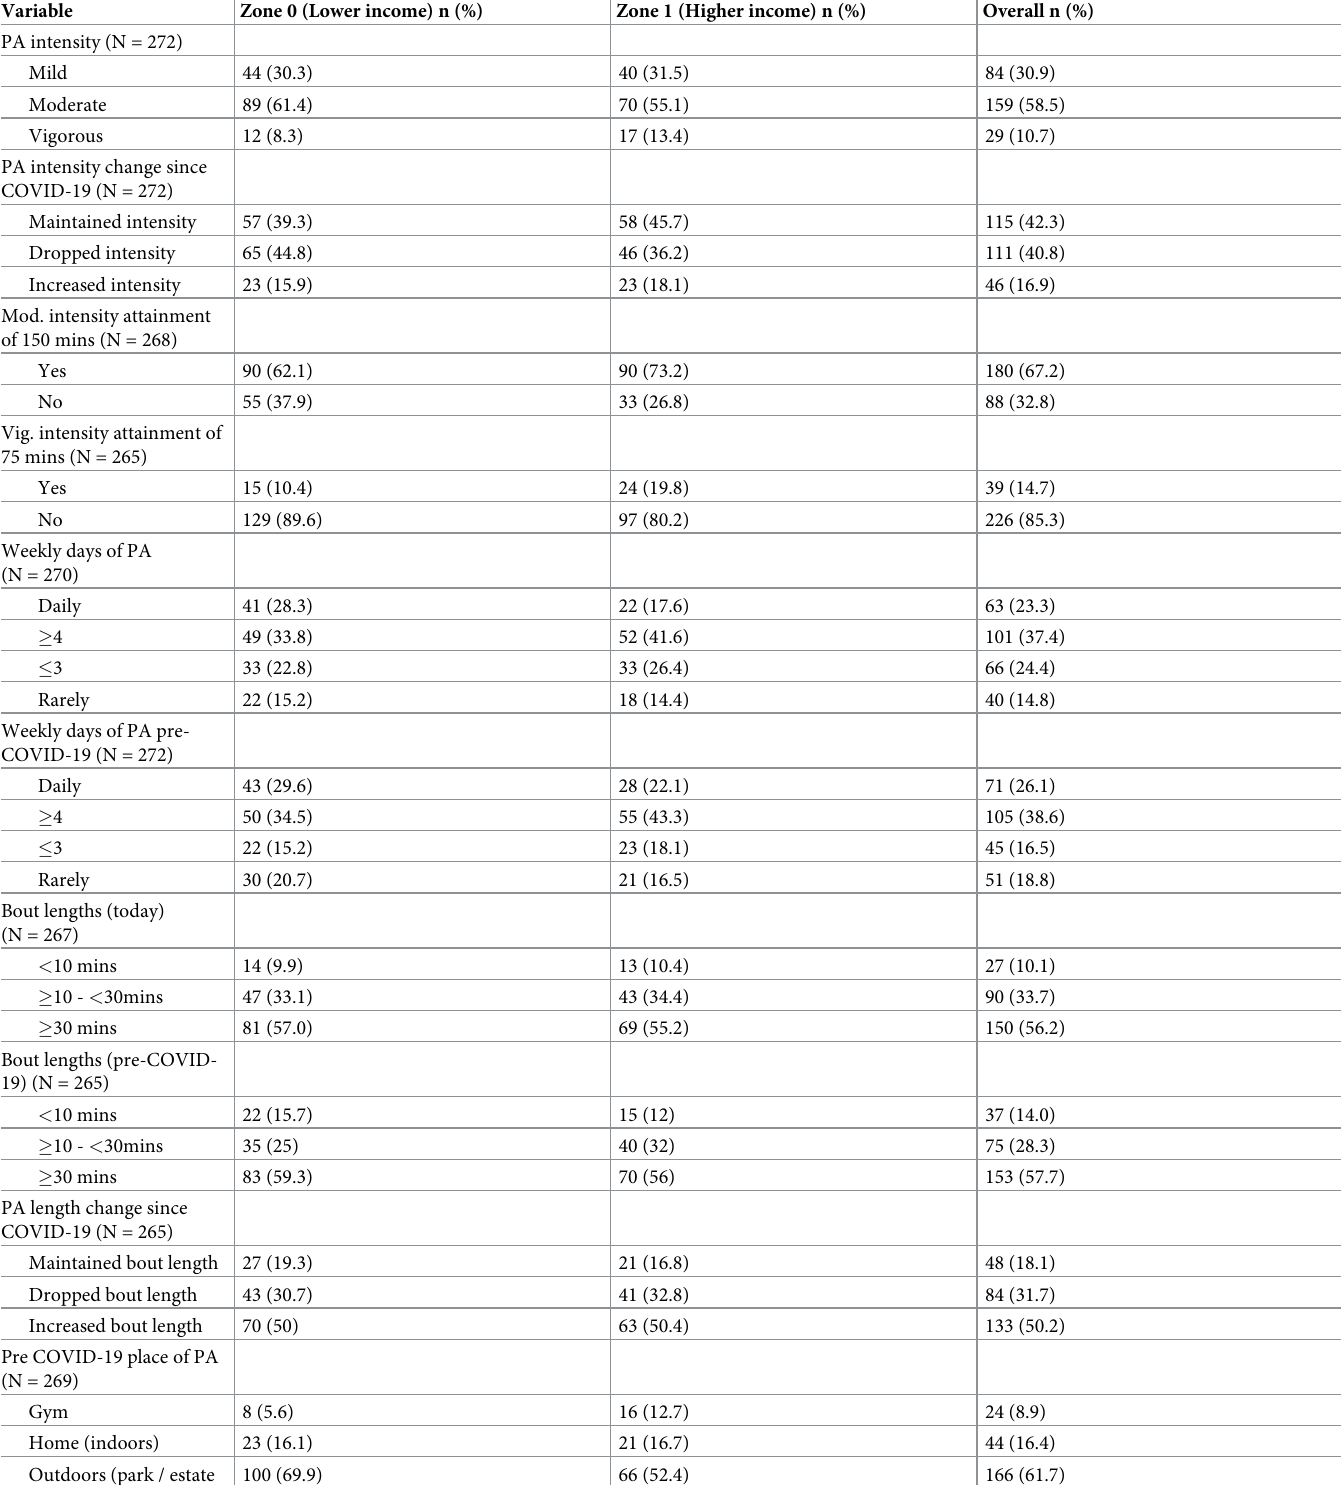
Table 3. Patterns of